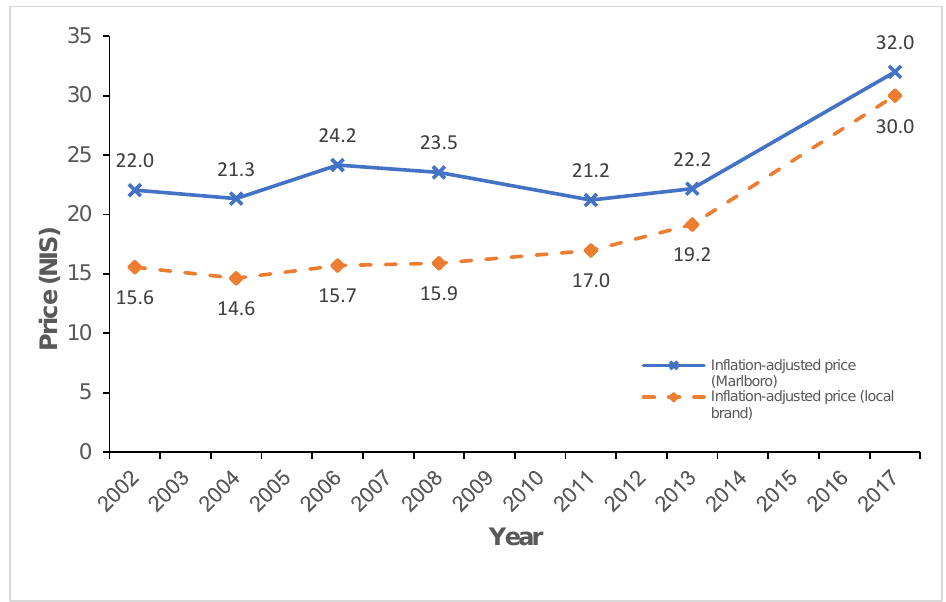
The blue ‘x’ and orange ‘rhombus’ shape depict the inflation adjusted price in NIS (New Israeli Shekel) of a 20 pack of cigarettes of Marlboro and the local brand (respectively) per KAP (knowledge, attitudes and practices) survey year: 2002, 2004, 2006, 2008, 2011, 2013, 2017. The base year for inflation adjustment is 2017. Prices were derived from the Economic Intelligence Unit. Figure 1. Cigarette Prices (Marlboro and Local Brand) by Survey Year.